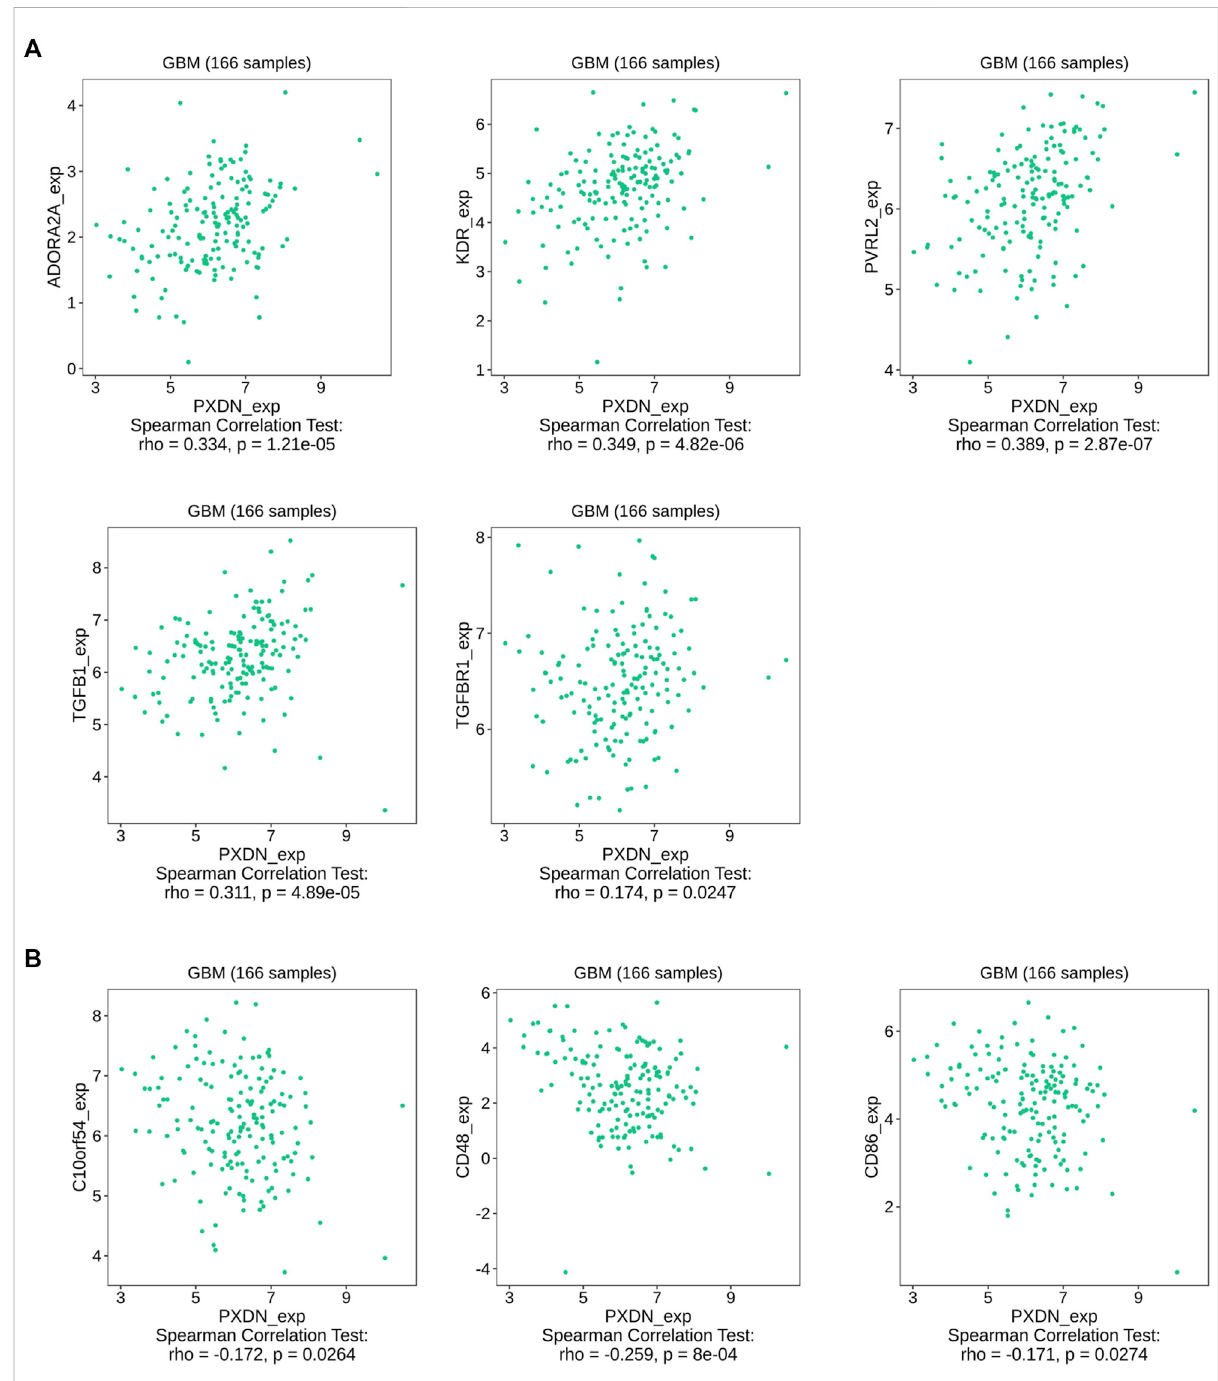
FIGURE 6 Association between PXDN and immunomodulators. (A) PXDN-related immunoinhibitors. (B) PXDN-related